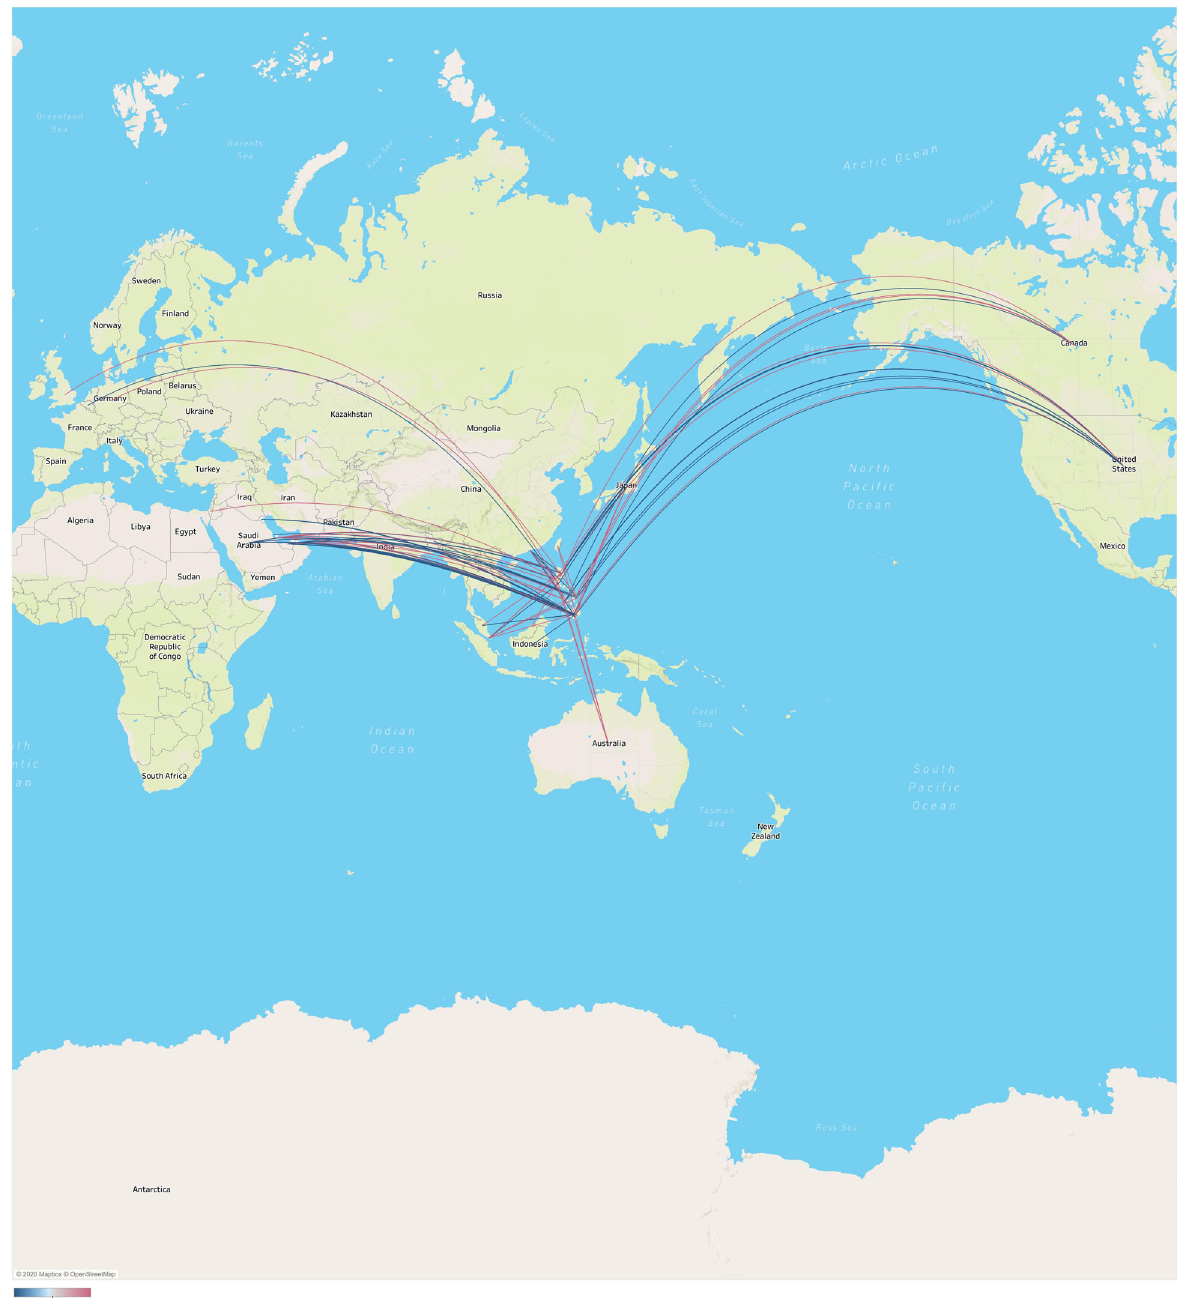
Fig. 2 Overview of the international migration movements. International migration fl ows generated from all 12 study sites (blue lines indicate male movements and red lines female